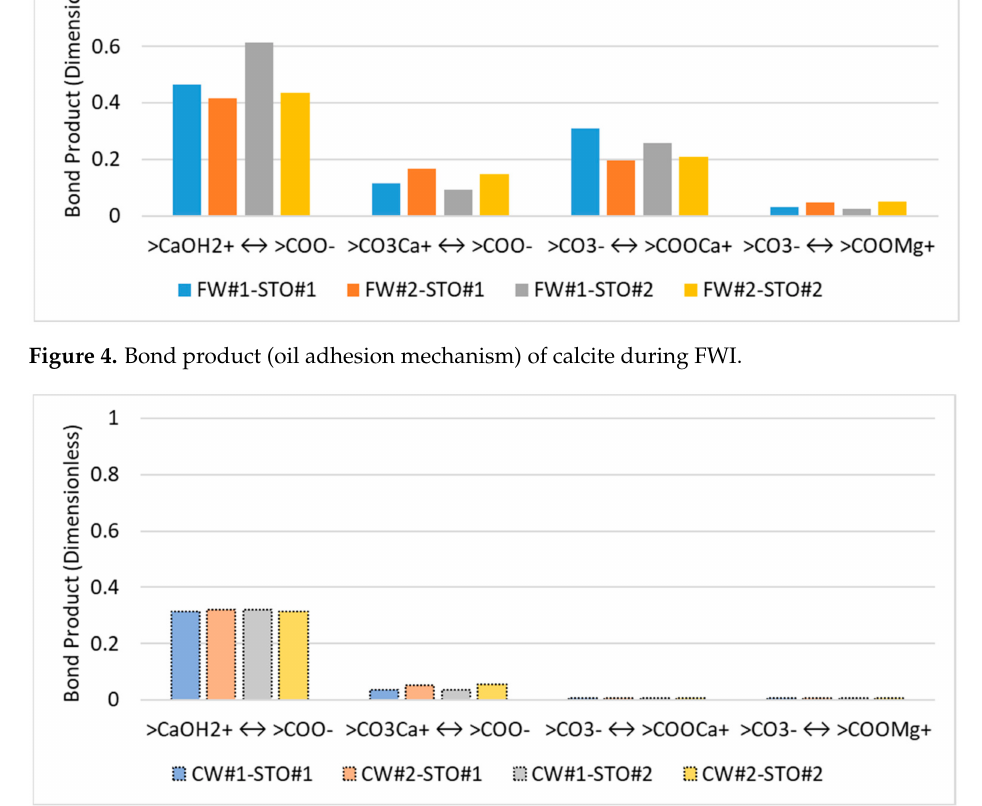
Figure 5. Bond product (oil adhesion mechanism) of calcite during